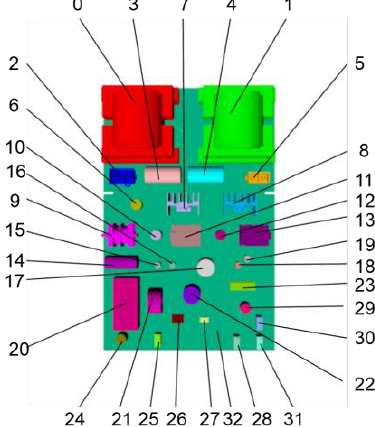
Figure 5. Color labels of the PCB components.